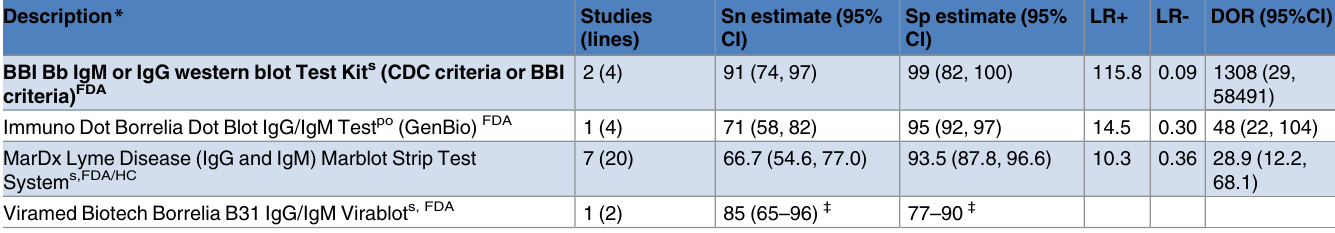
Table 4. Eight studies (33 lines of data) evaluating different immunoblots (2nd tier tests) at all stages of Lyme disease using hierarchical logistic regression models or the sensitivity and specificity data when less than four lines of data were available for meta-analysis. Description